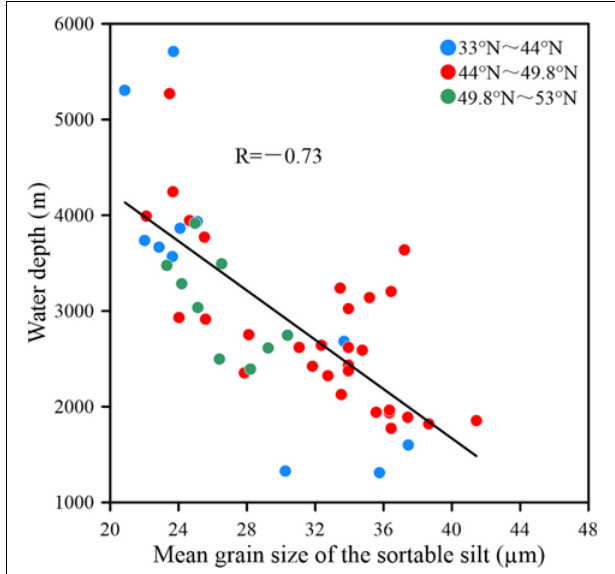
FIGURE 9 | The correlation plot between grain size of sortable silt and water depth.